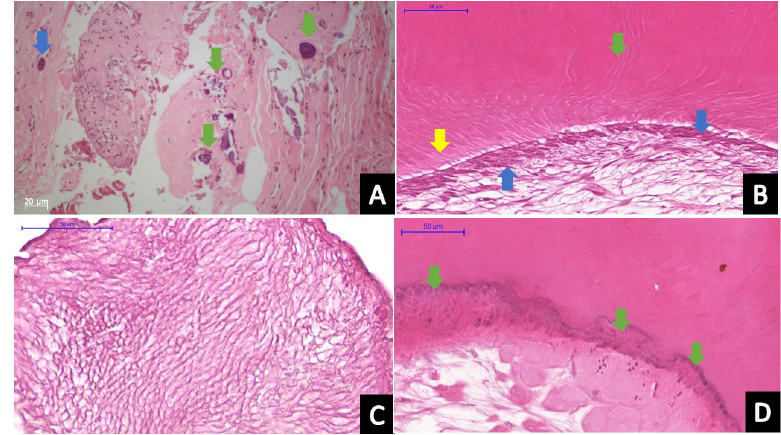
Figure 4. Histopathological analysis of the odontoma. A ) Connective tissue around the tumor showing bundles of collagen representing mineralized areas (green arrows) and an island of odontogenic epithelium (blue arrow); B ) pulpal tissue-like area, demonstrating delicate collagen fibers, a columnar layer of odontoblasts (blue arrows) related to the pre-dentin (yellow arrow) and the dentin matrix showing dentinal tubules (green arrow); C ) enamel matrix; D ) mineralized tissue similar to cement, presenting basophilic reverse lines (green